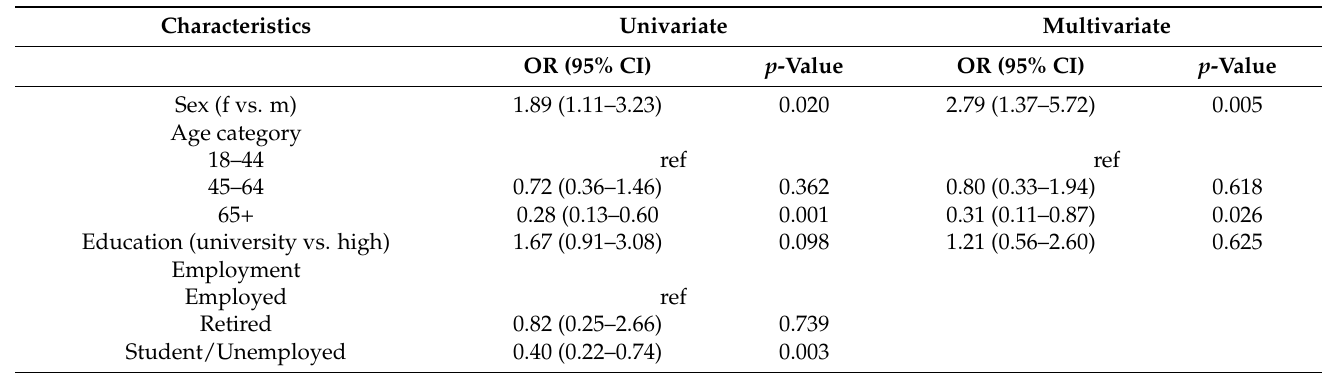
Table 5. Univariate and multivariate analysis of local adverse events 7 days after the booster dose of COVID-19